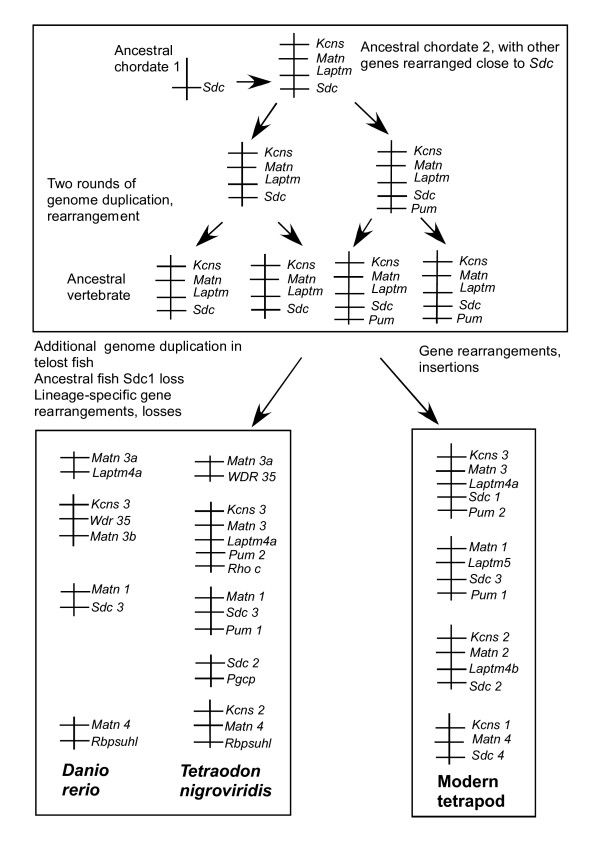
Model for the evolution of syndecans in fish and tetrapods. The upper panel of the model shows the hypothesized ancestral genomic context of a single syndecan gene, originating in an ancestral chordate (chordate 2) subsequent to the divergence of the Urochordate lineage. The model assumes that four-fold paralogy was then set up in an ancestral vertebrate as a result of two rounds of whole-genome duplication. This process also sets up pairing within each set of paralogues. The lower right hand panel represents how the initial complete paralogy has degenerated through gene rearrangements in modern tetrapods. Fish underwent an additional round of genome duplication that would have generated additional paralogous pairs [58]. The lower left-hand panel represents the situation in two modern fish, in which only the two matrilin-3 paralogues have been retained from FSGD. The syndecan-1 locus appears to have been lost early in the fish lineage. Other gene rearrangements or losses appear specific to the zebrafish or pufferfish lineages.